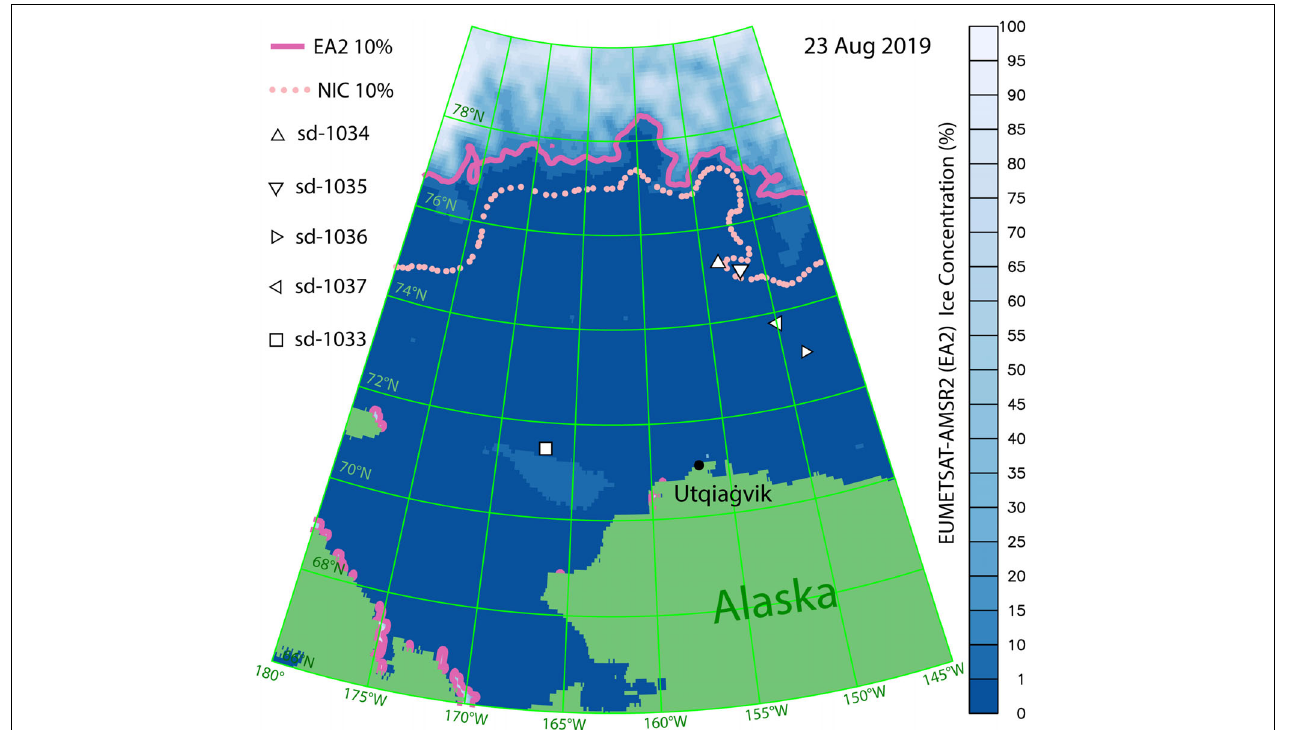
FIGURE 3 | The Eumetsat-AMSR2 (EA2) estimate of ice concentration (blue-white hues) and 10% ice contour (solid purple curve) along with the NIC ‘ice edge’ 10% contour (pink dotted curve) and locations of saildrones sd-1033 (square), sd-1034, sd-1035, sd-1036, and sd-1037 (triangles) on 23 August 2019, the date of the mission’s last ice encounter (sd-1035).